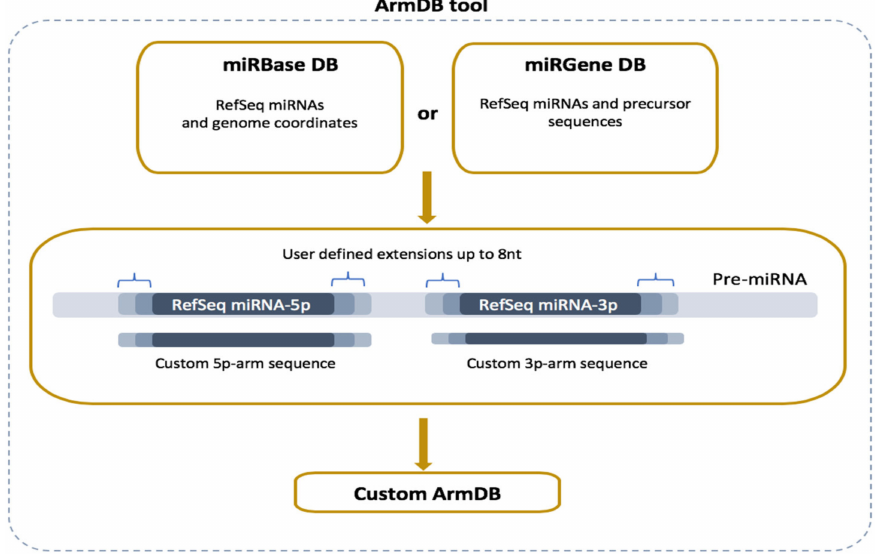
Figure 2. Overview of ArmDB tool. The tool can use data from miRBase or miRGene DBs to generate a custom database with 5 (cid:48) - and 3 (cid:48) -arm sequences used as a reference for read mapping in downstream analysis. The arms can be generated with user-defined nucleotides extension of the RefSeq sequences (up to 8